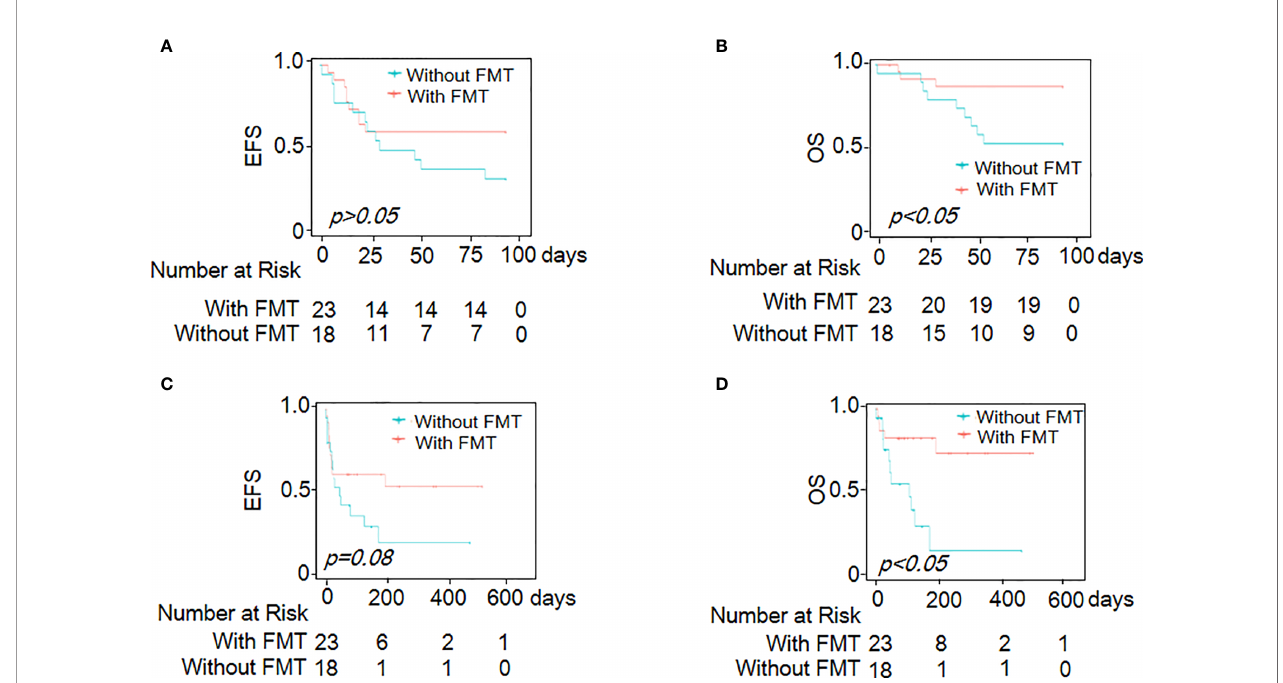
FIGURE 3 | Kaplan-Meier curves demonstrating survival outcomes. EFS (A) and OS (B) of all patients within 90 days of follow-up time; EFS (C) and OS (D) at the end of research.